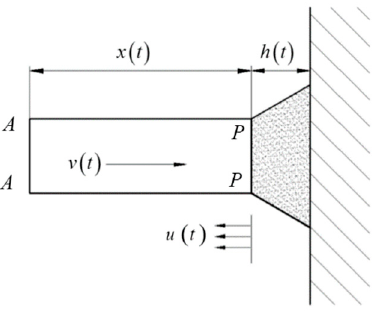
Figure 21. Taylor impact analysis diagram of the blunt projectile.